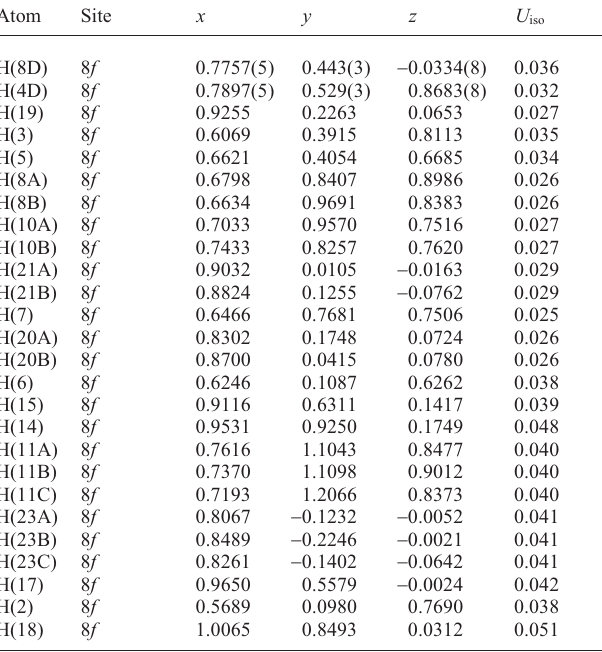
Table 2. Atomic coordinates and displacement parameters (in Å 2 )